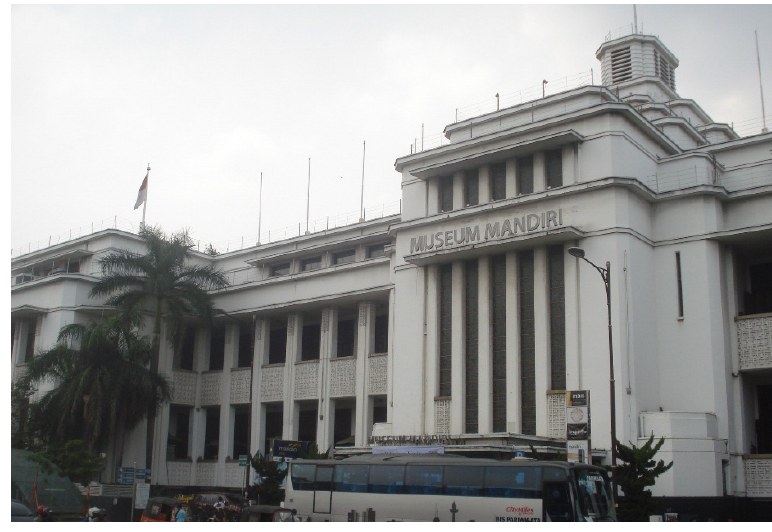
Figure 2. The Bank Mandiri Museum in Jakarta.